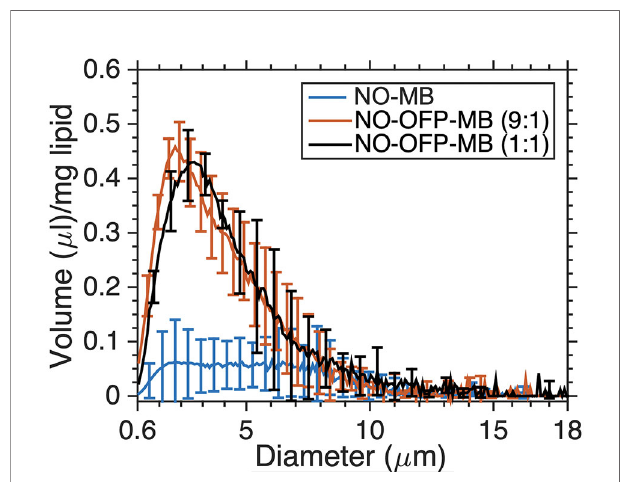
FIGURE 4 | The volume-weighted size distribution of NO-MB and NO-OFP- MB (9:1 v/v and 1:1 v/v). The mean ± 1 standard deviation is depicted (n = 3 per